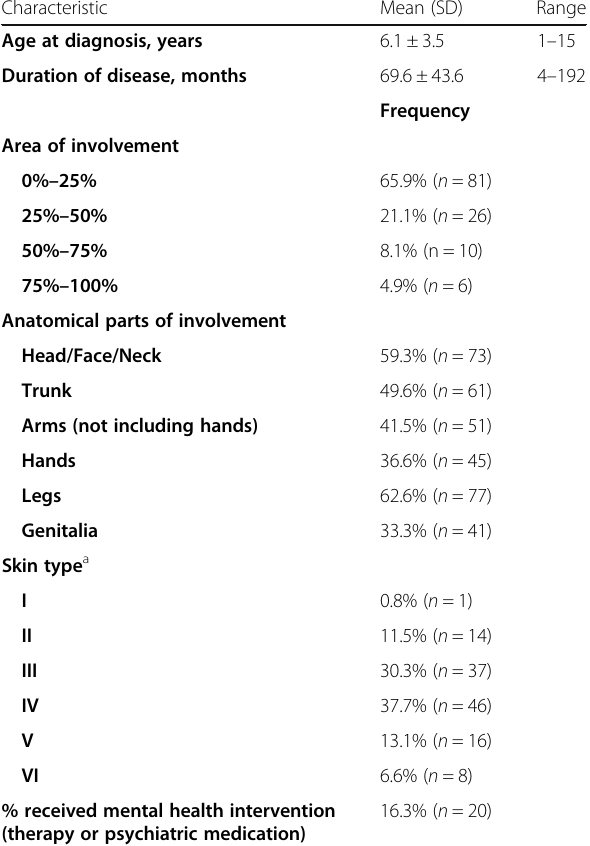
Table 1 Characteristics of patient participants with vitiligo Characteristic